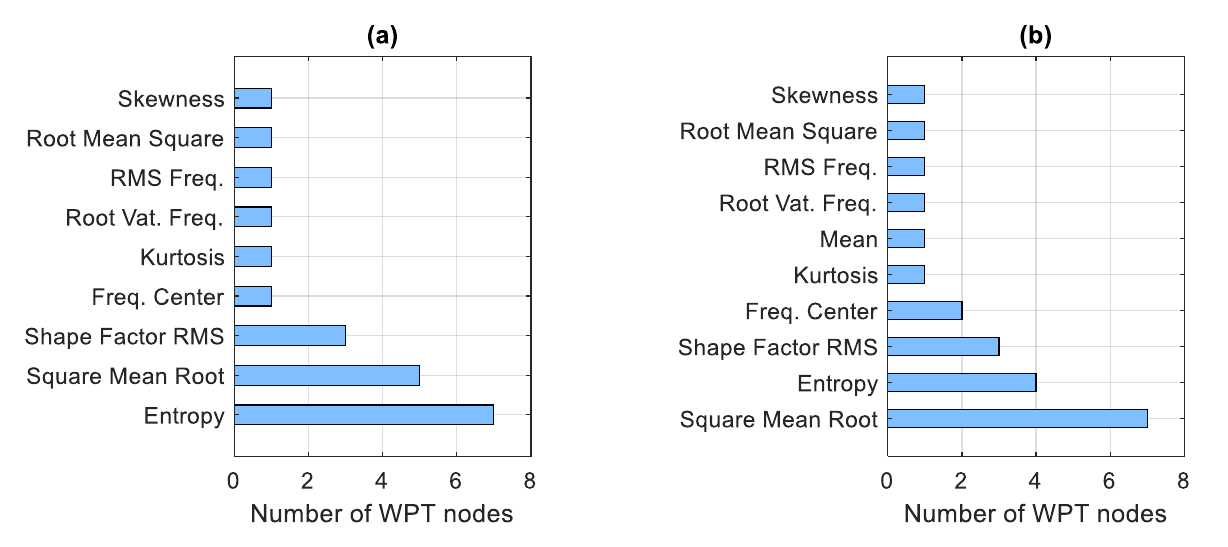
Figure 10. The number of nodes in which the given features were selected by Boruta: ( a ) Dataset with artificial damages; ( b ) Dataset with real damages.